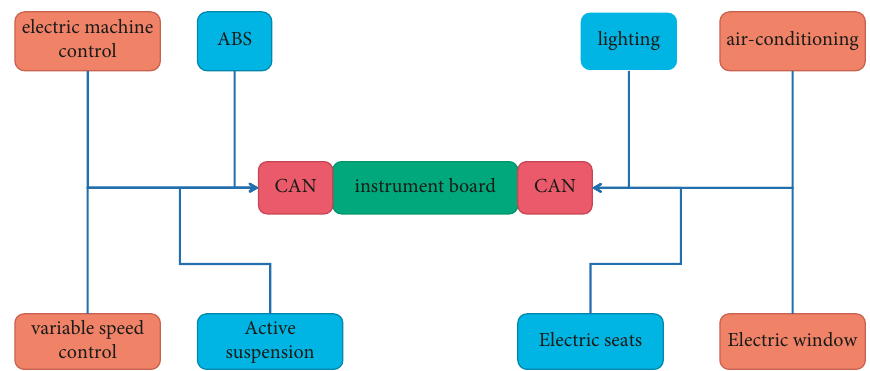
Figure 2: Application of automobile CAN bus. Table 1: Experimental